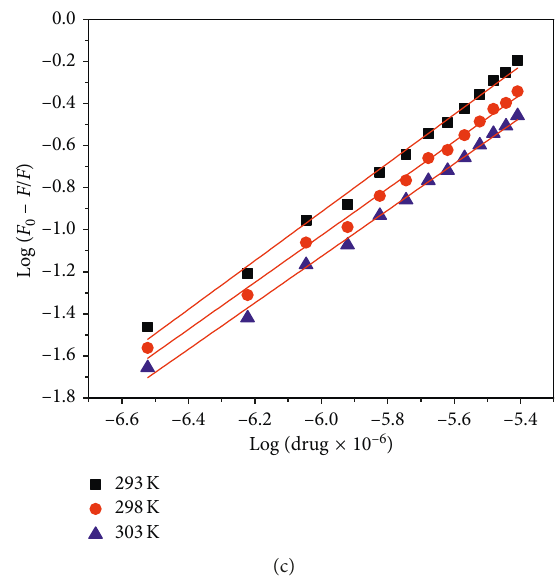
Figure 2: (a) Steady-state emission fluorescence spectroscopy studies of human serum albumin (1 µ M) with the coumarin derivative complex (0–3.6 µ M, 0.3 μ M intervals). (b) The Stern–Volmer quenching constant of the HSA-coumarin derivative complex with different temperatures. (c) The double logarithmic plot of HSA with the coumarin derivative complex at different